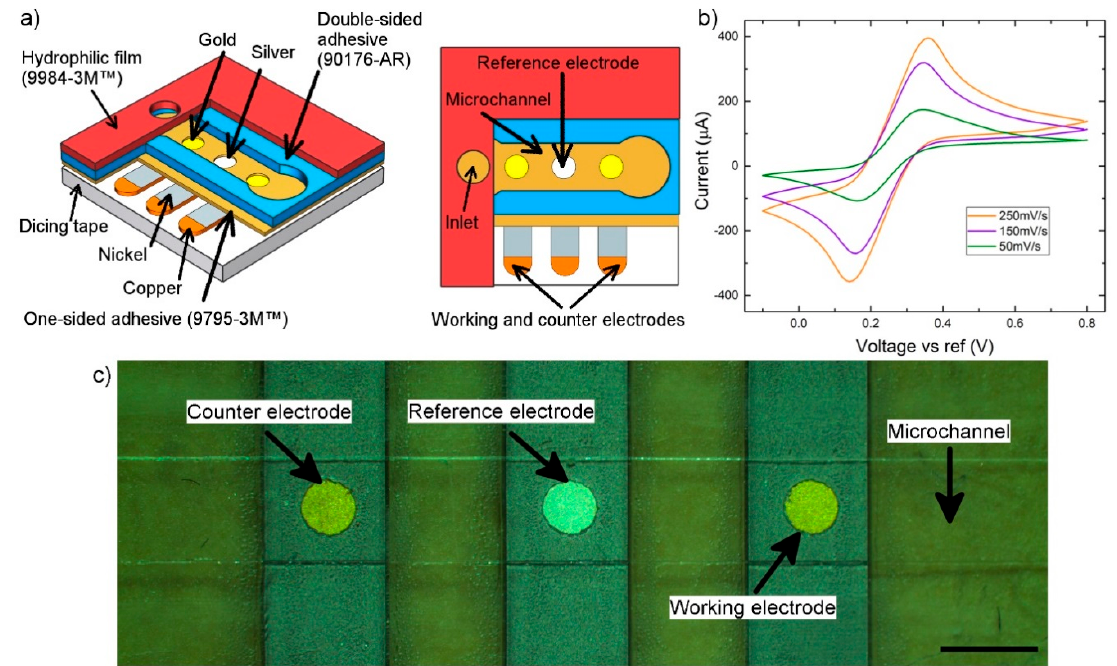
Figure 6. An integrated microfluidic sensor. ( a ) Layer-by-layer structure of the microfluidic device; ( b ) cyclic voltammogram of 100 mM ferricyanide/ferrocyanide; ( c ) microchannel and three-electrode system in a microfluidic sensor (scale bar = 2 mm).